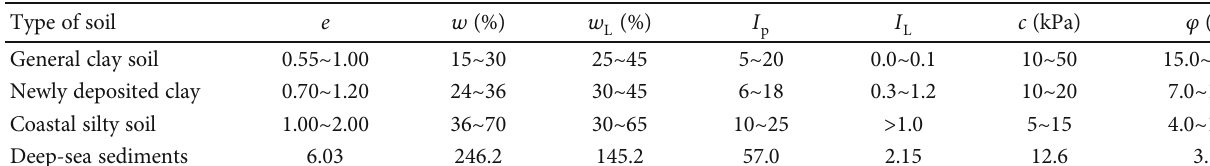
Table 6: Physicomechanical property parameters of di ff erent origin clays.